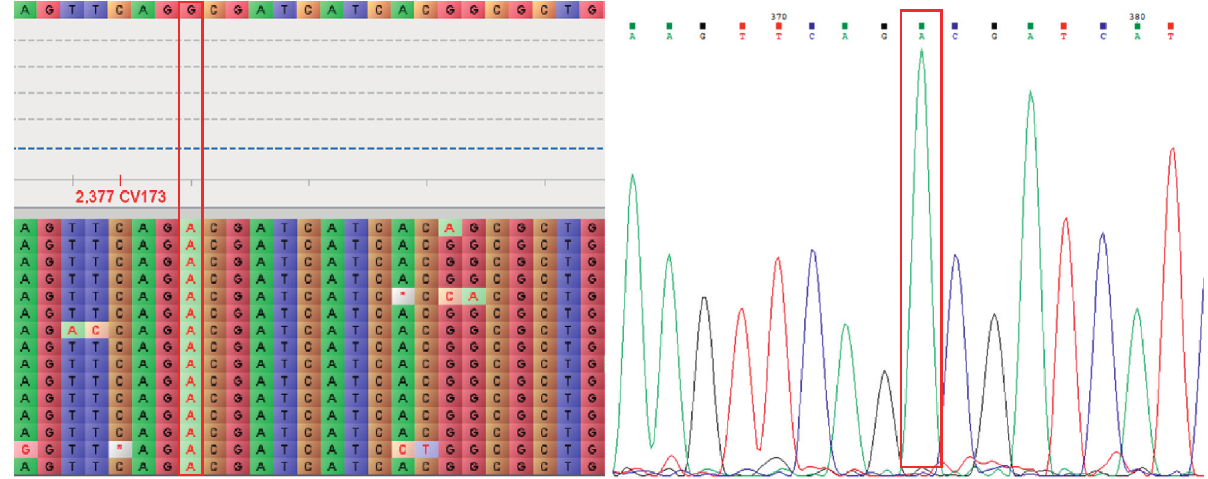
Figure 2: The gyrB (G1510A) variant in sample Y105 detected using Oxford Nanopore Technology sequencing and verified by Sanger